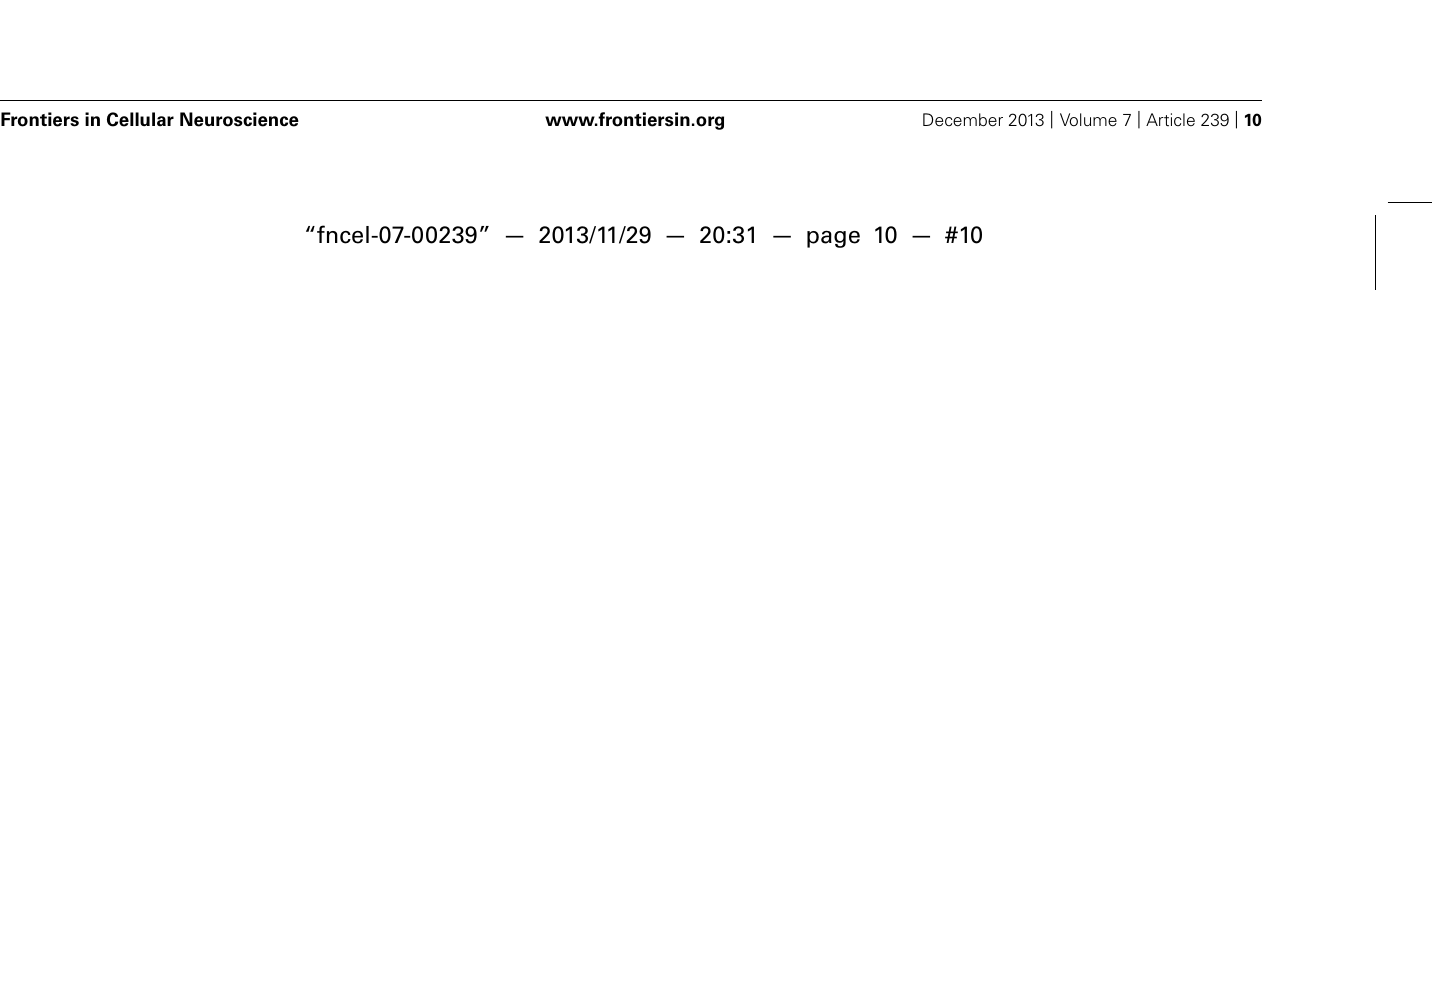
FIGURE 6 |TheWnt/ β -catenin signaling increases in control NSC34hSOD1WT cells but not inALS-like NSC34hSOD1G93A cells, possibly due to the presence of β -catenin aggregates. (A) Cells were seeded on PLL/gelatin-coated dishes and transfected with theWnt reporter TOPFLASH vector plus the pRLSV40 Renilla control plasmid, and subsequently differentiated for the indicated times.The graph shows the normalized reporter gene activity (luciferase/Renilla). Data are expressed as the average ± SEM of three independent experiments performed by quadruplicate ( ∗ p < 0.05, paired t test). (B) Total protein extracts were obtained from differentiating NSC34hSOD1 cells at 0, 24, and 36 h and were subjected to western blot analyses using an anti β -catenin antibody. An